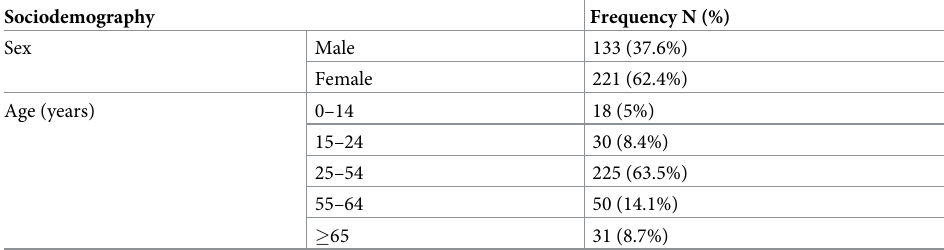
Table 1. Sociodemography.